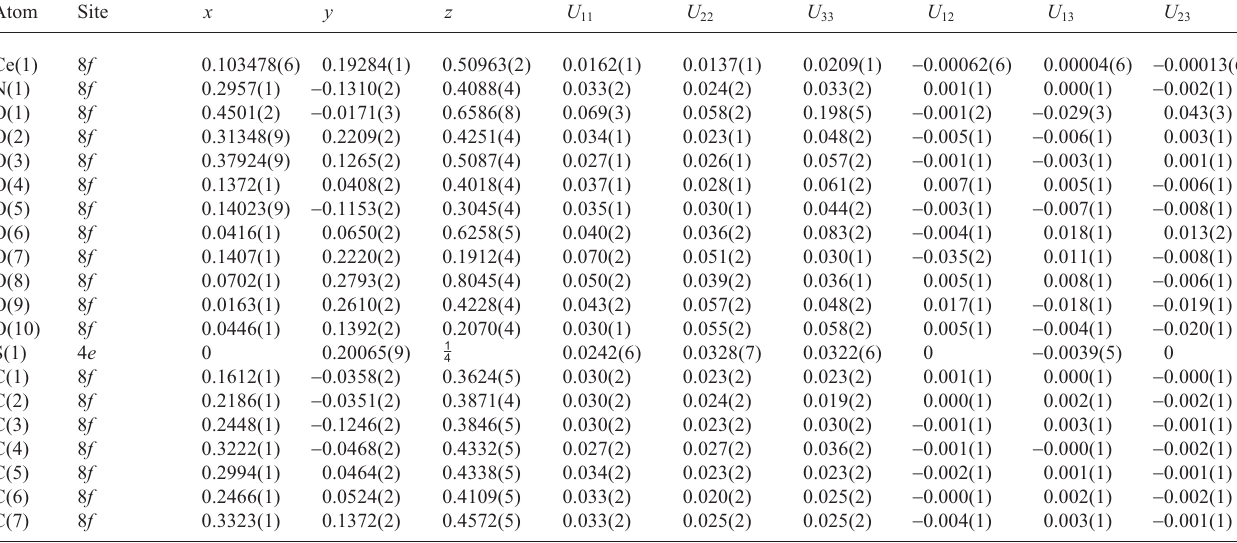
Table 3. Atomic coordinates and displacement parameters (in Å 2 )